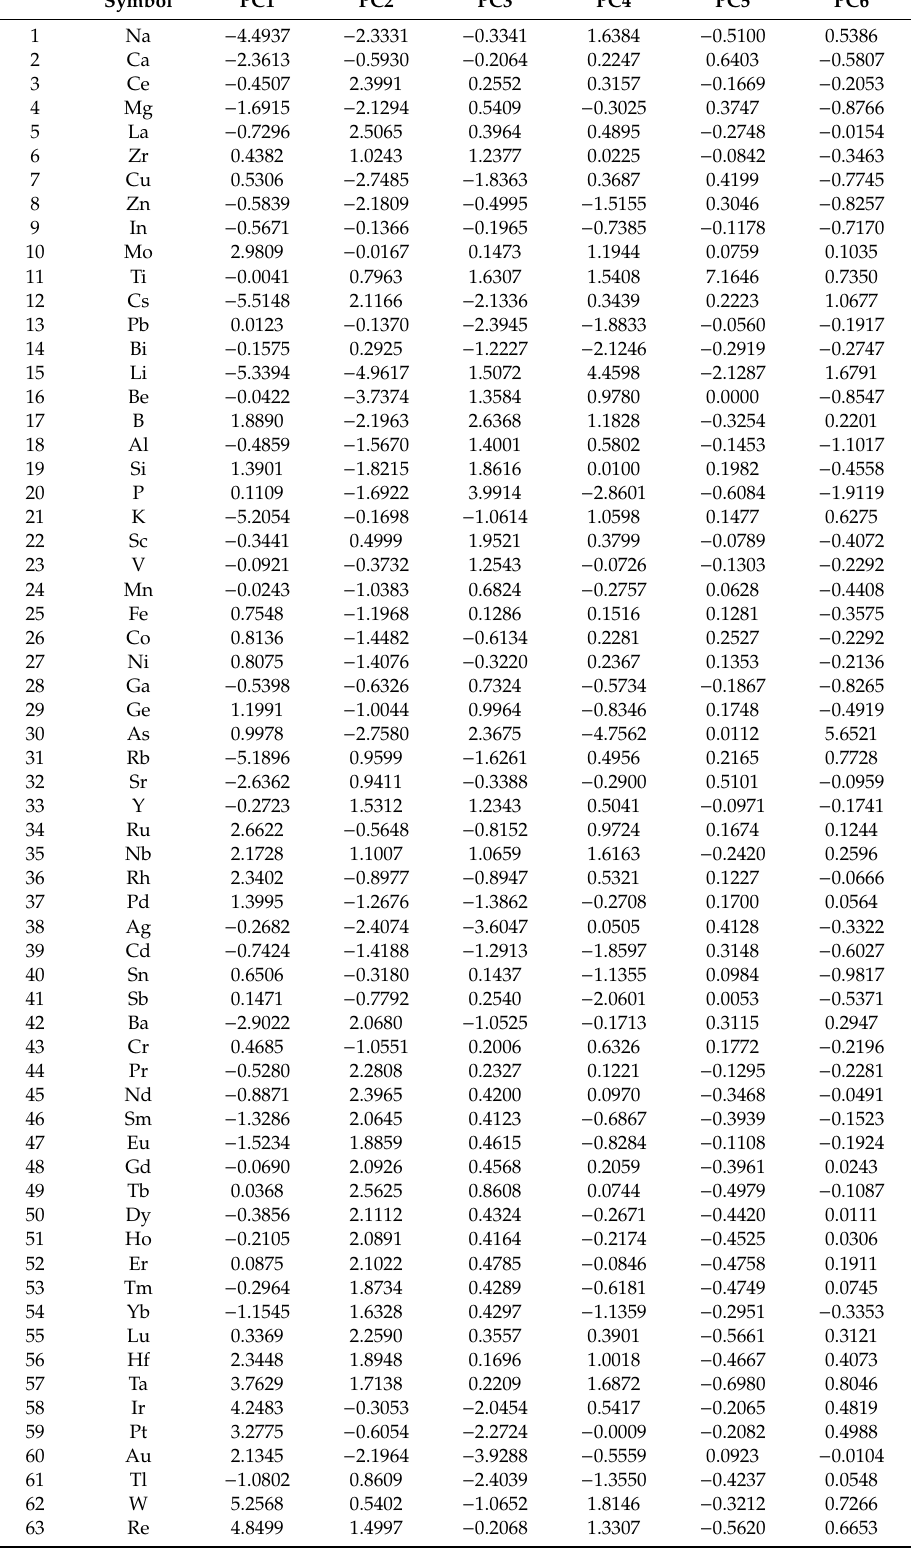
Table 4. Principal